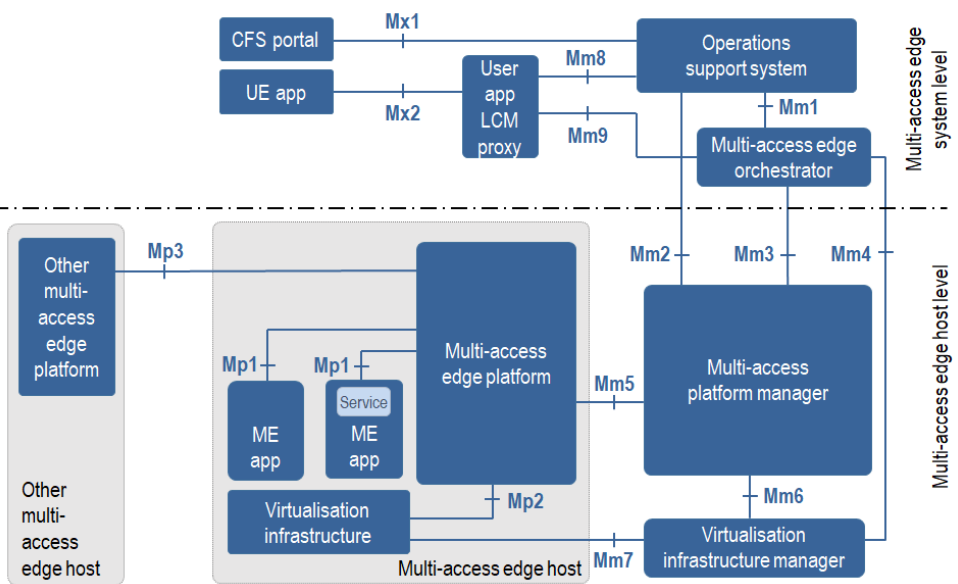
Figure 1. European Telecommunications Standards Institute (ETSI) multi-access edge computing (MEC) reference architecture.